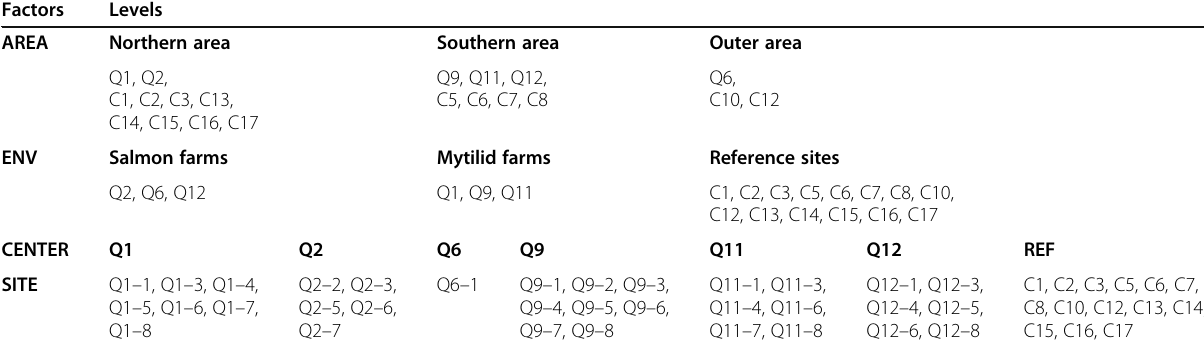
Table 1 Classification of sampling sites according to factor analysis performed with PERMANOVA. The factors were channel area (AREA), environment (ENV), farming center (CENTER) and sampling sites (SITE). Q i corresponds to aquaculture sites, REF corresponds to reference sites. See also Fig. 1 and Methods for